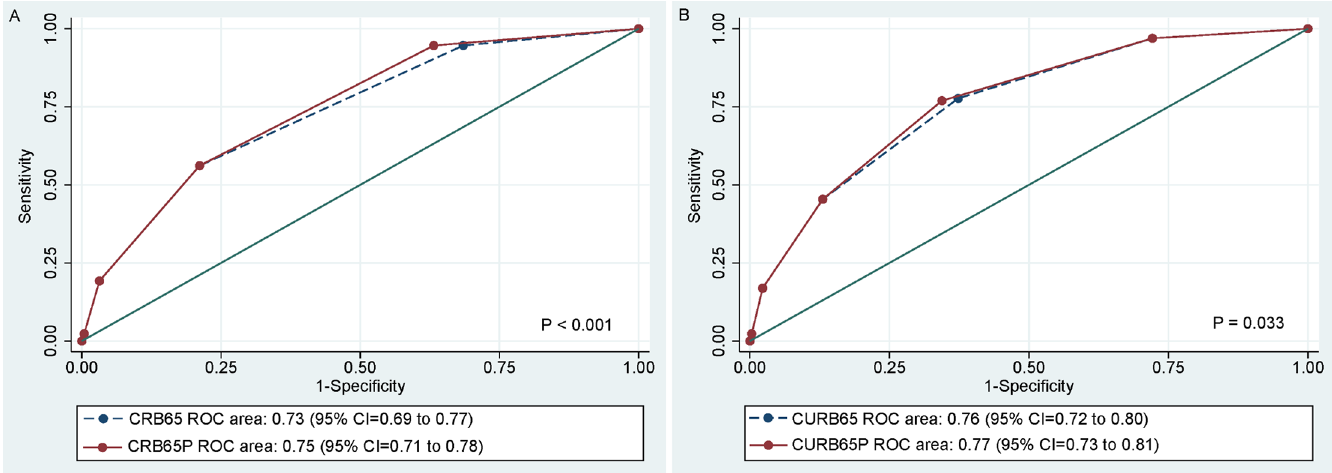
Fig 2. Comparison of AUCs for scoring systems before and after modification. (A) CRB65 (before) and CRB65P (after), (B) CURB65 (before) and CURB65P